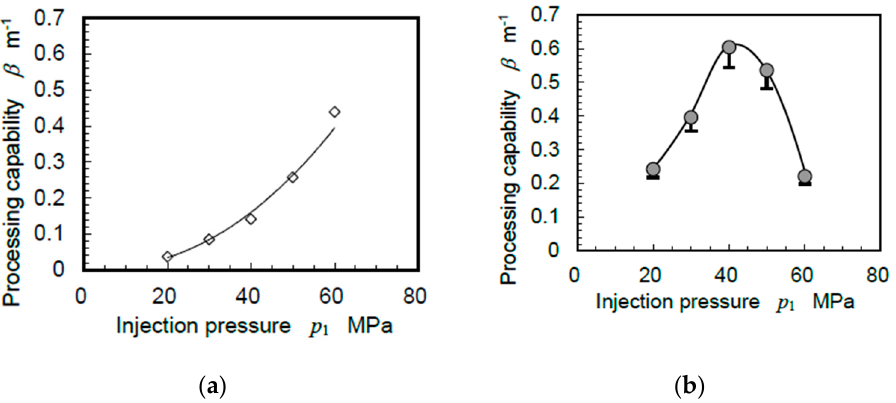
Figure 14. Effect of injection pressure on the aggressive intensity of cavitating jet at constant downstream pressure condition; ( a ) 1st peak; ( b ) 2nd peak [92].